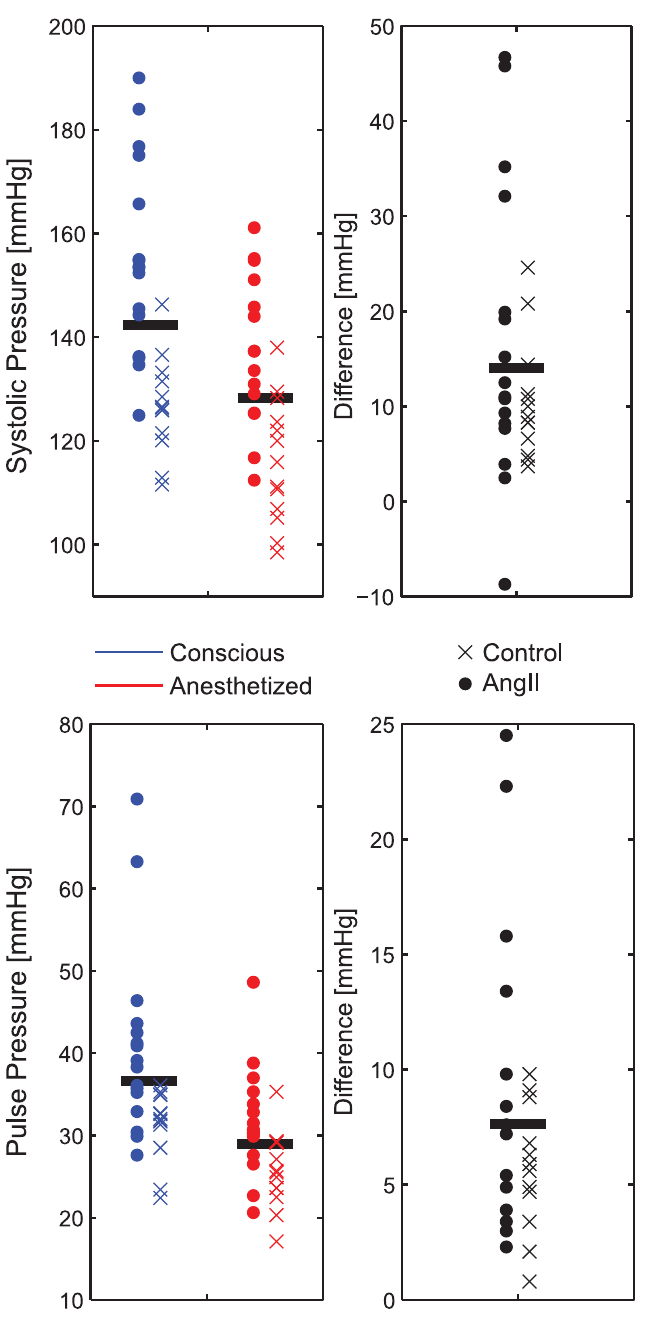
Fig 3. Comparison of Conscious and Anesthetized Blood Pressures. Left Panels- Scatterplot comparison of systolic (top) and pulse (bottom) arterial pressure measurements via implanted telemetry under conscious (blue) and anesthetized (red) conditions. Horizontal bars represent the measurement mean. Right panels- Scatterplot of the differences between conscious and anesthetized measurements on a subject-by-subject basis. Circles denote subjects infused with AngII while ‘ x ’ s denote controls. Horizontal bars represent the measurement